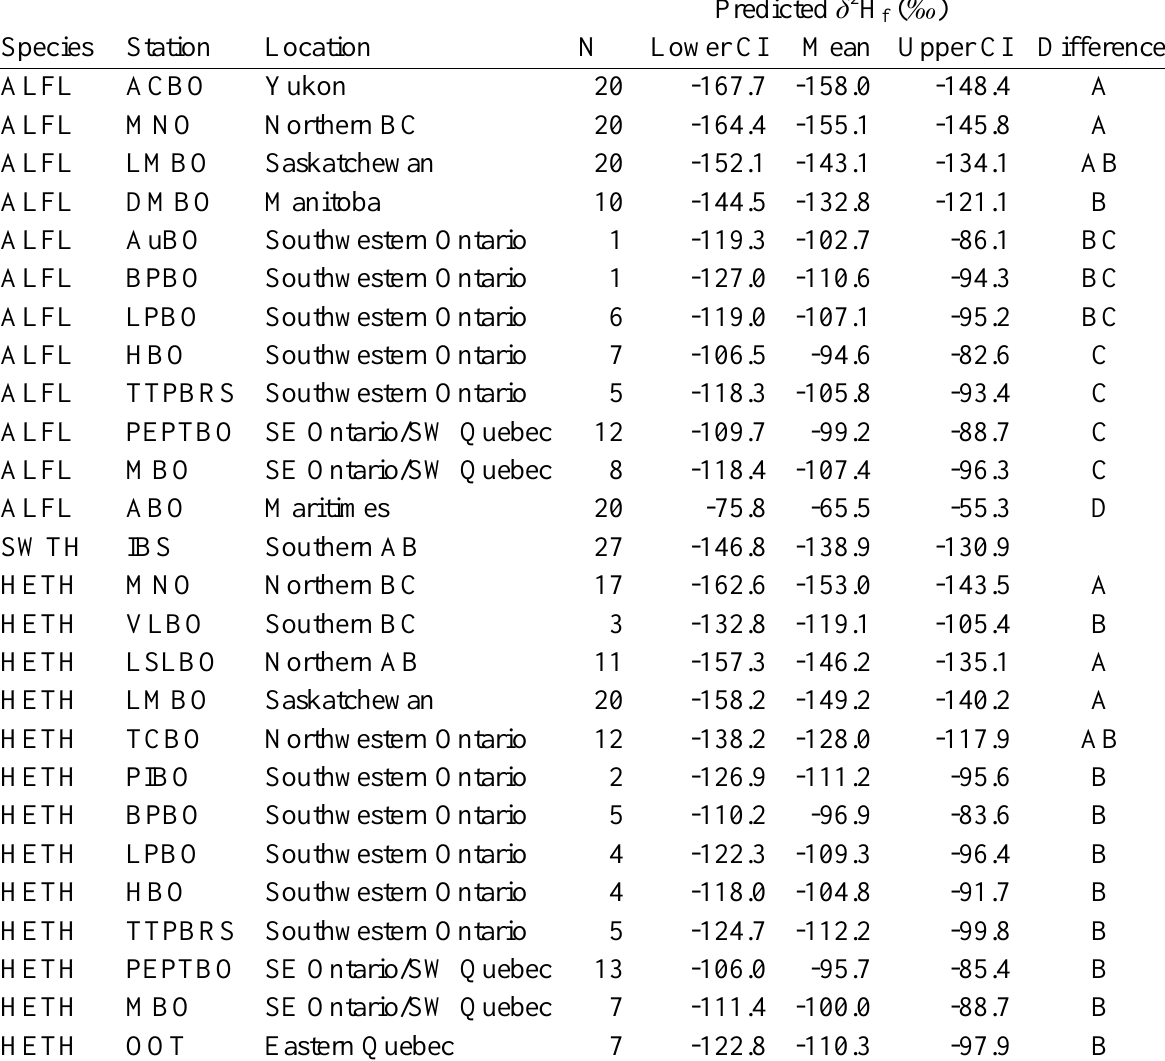
Table A1.2. Predicted mean δ 2 H and 95% Confidence Intervals from linear mixed effects models f examining variation in δ 2 H from 14 species of passerine captured at Canadian Migration Monitoring f Network Stations during fall migration (n = 1855 individuals). Stations arranged by numbers in Fig. 1. Identical letters in the Difference column indicate overlap of 95% Confidence Intervals with other CI’s for the same